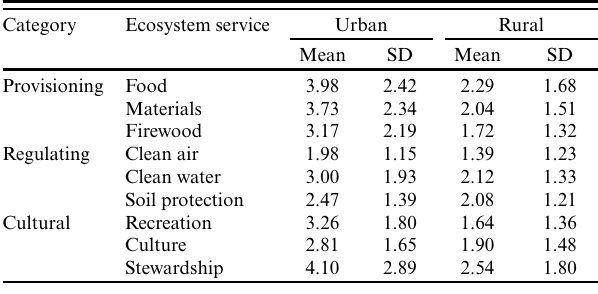
Table 2 . Mean number of limitations and standard deviation per ecosystem service per person in urban and rural